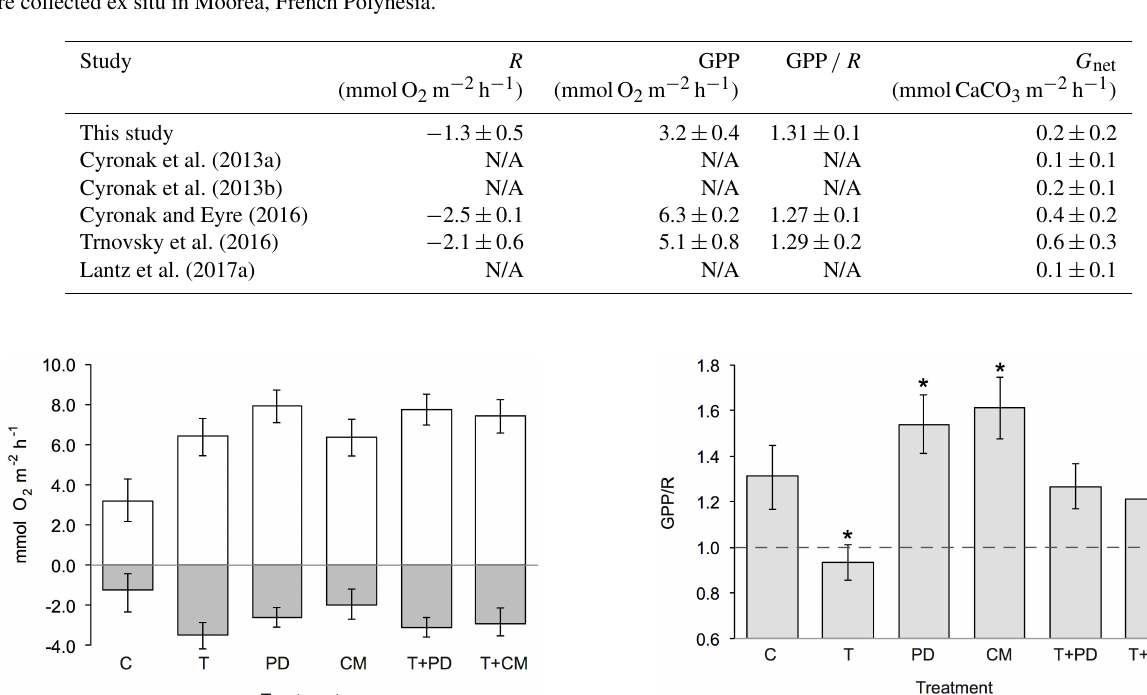
Table 4. A comparison of studies which employed the same methodology (advective chamber incubations) under a similar advection rate ( ∼ 43Lm − 2 d − 1 ) and calculated gross primary productivity (GPP: mmolO 2 m − 2 h − 1 ) , respiration ( R : mmolO 2 m − 2 h − 1 ) , the ratio of